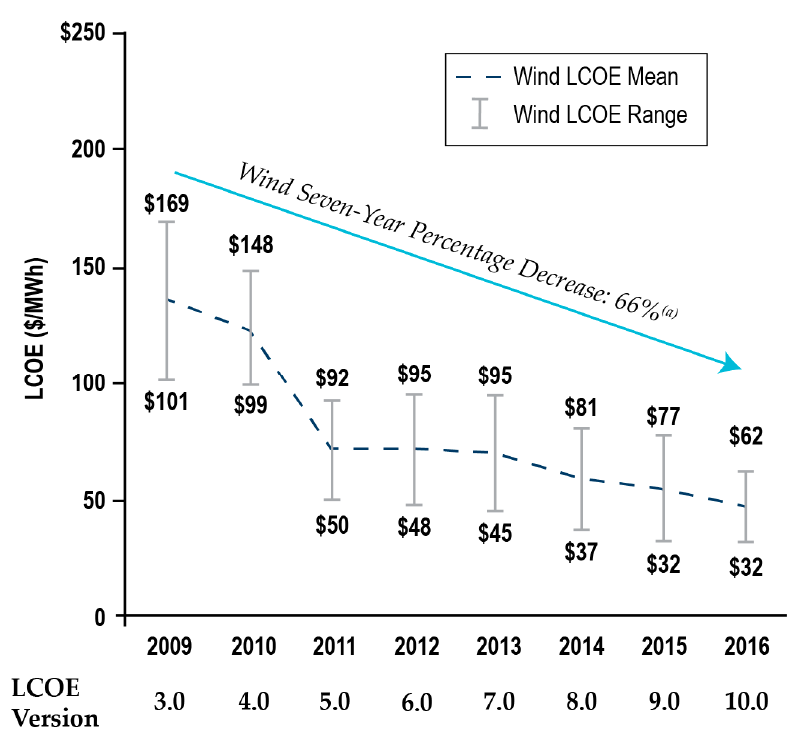
Figure 4. The LCOE of utility-scale wind energy for the period 2009–2016. Adapted from [4].